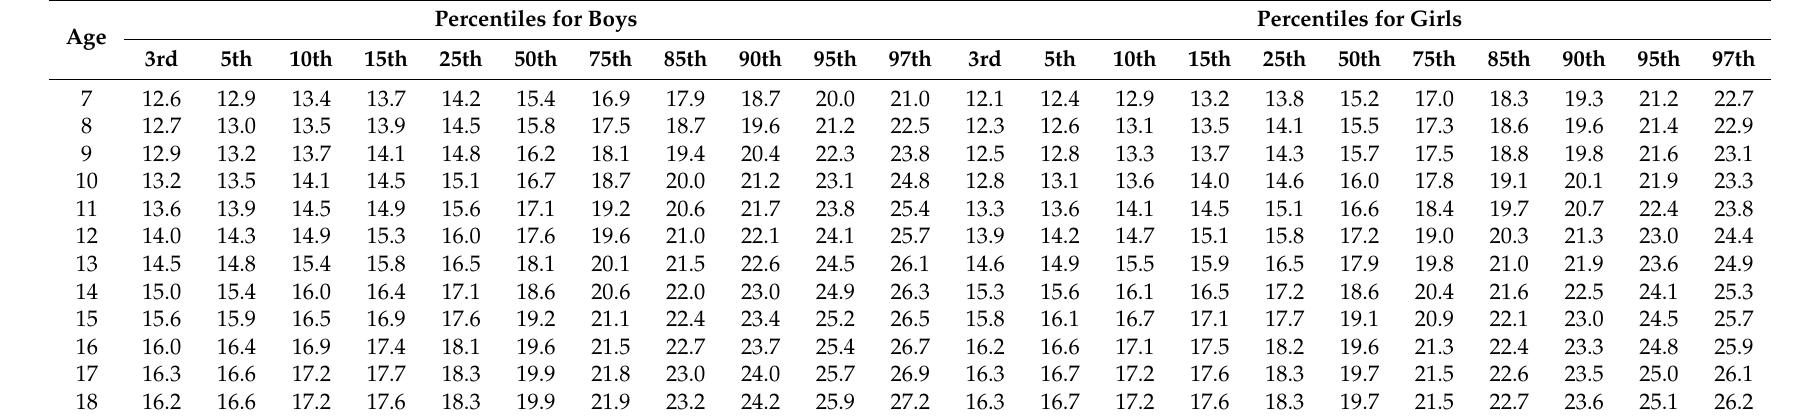
Table 2. Gender- and Age- specific BMI percentile values for Chinese children and adolescents aged 7–18 years ( n = 5062). Percentiles for Boys Percentiles for Age